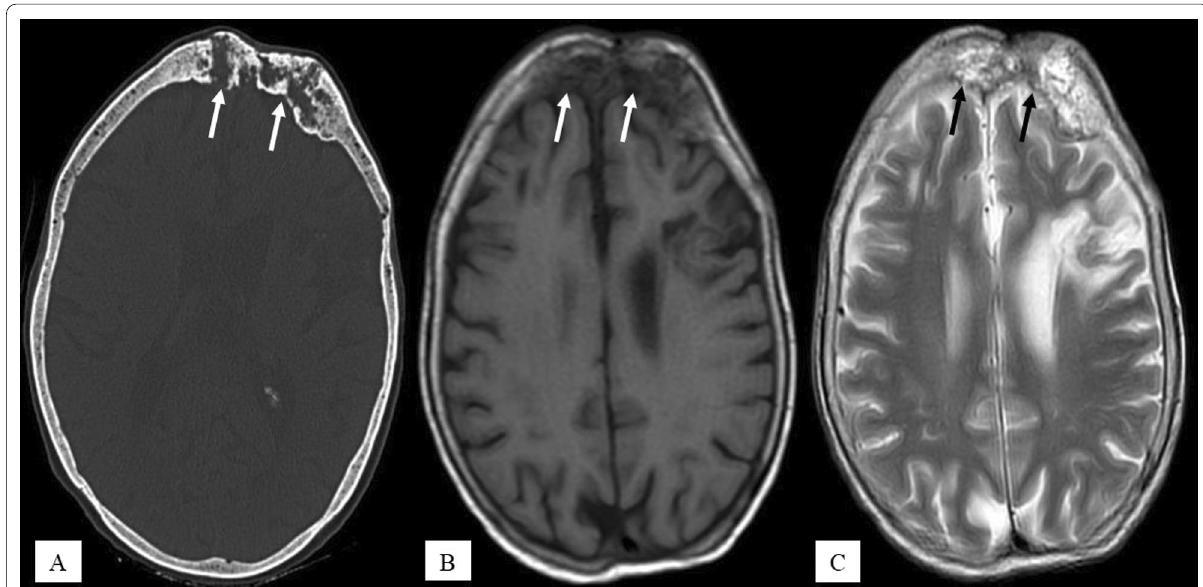
Fig. 2 Evaluation of margins of lesion by CT and MRI in a 55 year old female known case of carcinoma lung with skull metastases ( A ) CT bone window image shows a large mixed (lytic sclerotic) lesion with ill defined margins. MRI T1W ( B ) and T2W ( C ) images show a large mixed intensity + lesion with ill defined margins. Margins of the lesions in this case can be easily classified as ill defined on both CT and